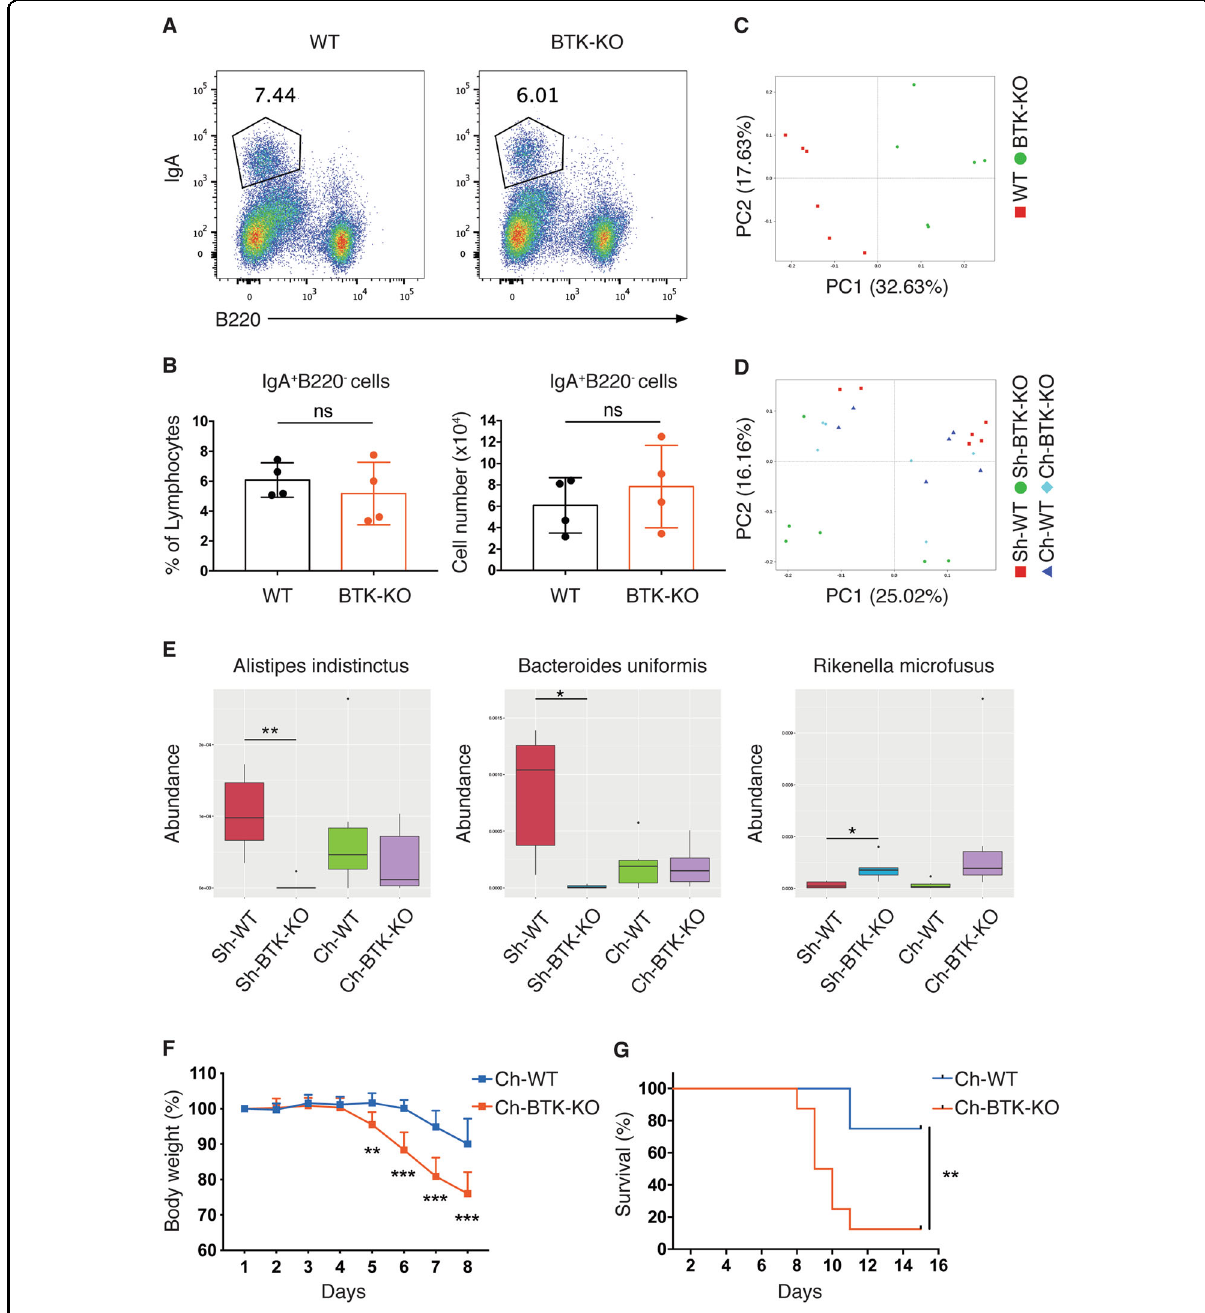
Fig. 2 Increased colitis severity in BTK-KO mice is not due to gut microbiota shift. A Colon LP lymphocytes from WT and BTK-KO mice stained as indicated to reveal IgA-expressing B cells (IgA + B220 - ). Numbers shown are percentage of cells in the indicated gates. B Frequency (left) and total number (right) of IgA-expressing B cells in lymphocytes from colon LP of WT and BTK-KO mice. C – E Fecal bacteria composition of WT and BTK-KO mice analyzed by 16 S rRNA gene V3 – V4 region sequencing. PCoA plot (based on unweighted UniFrac distance) of fecal bacteria was generated for singly-housed WT and singly-housed BTK-KO mice ( C ), and for singly-housed WT (Sh-WT), singly-housed BTK-KO (Sh-BTK-KO), co-housed WT (Ch-WT) and co-housed BTK-KO (Ch-BTK-KO) mice ( D ). E Metastat analysis of fecal bacteria species differentially abundant between WT and BTK-KO mice before and after cohousing. F , G WT and BTK-KO mice were cohoused at 1:1 ratio for 4 weeks. Experimental colitis was induced in co-housed BTK-KO (Ch-BTK-KO) and co-housed WT (Ch-WT) mice by giving drinking water containing 2% (w/v) DSS for 7 days. Body weight ( F ) and survival rate ( G ) of Ch-WT and Ch-BTK-KO mice were monitored every 24 h. Data are presented as mean ± SD for B and F , median with interquartile range for E [ n = 4 for B , 6 for C – E and 8 for F , G ]. Statistical signi fi cance in B , F was determined by two-sided independent sample Student ’ s t -test. Survival rate difference in G was determined by Log-rank (Mantel – Cox) test. ns: not signi fi cant; * P < 0.05, ** P < 0.01 and *** P < 0.001 for B , F , G ; * q < 0.05, ** q < 0.01 for E